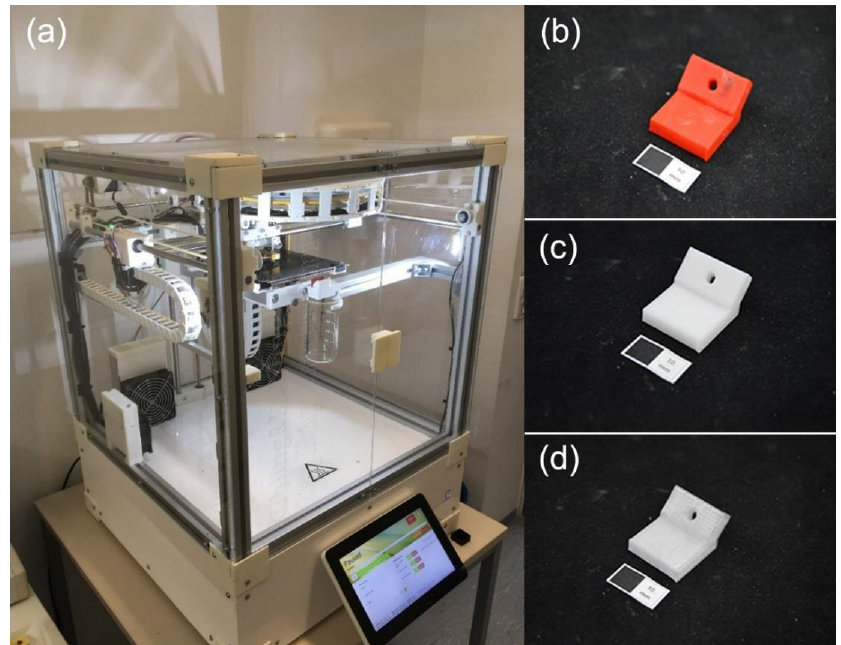
Figure 2. Additive manufacturing of test blocks. ( a ) RepRap Industrial fused deposition modeling (FDM) 3D-printer; ( b ) Test block printed with ABS; ( c ) Test block printed with HIPS; ( d ) Test block printed with PETG (white scale: 10 mm).